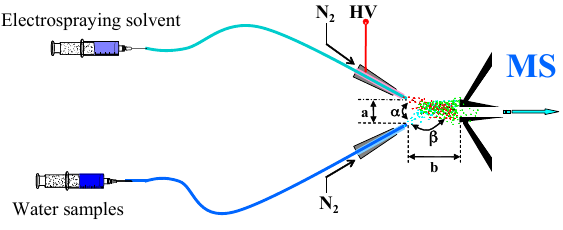
Figure 1. Schematic diagram of the EESI source.